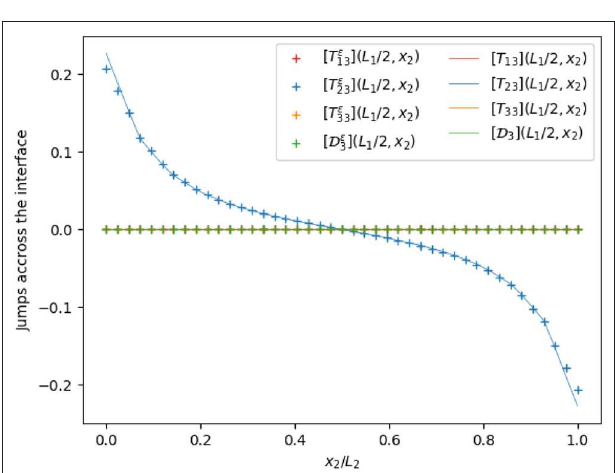
FIGURE 5 | Jumps of the displacement field and the electric potential across the interface on a line along the x 2 axis, with ε/ h = 0.1.